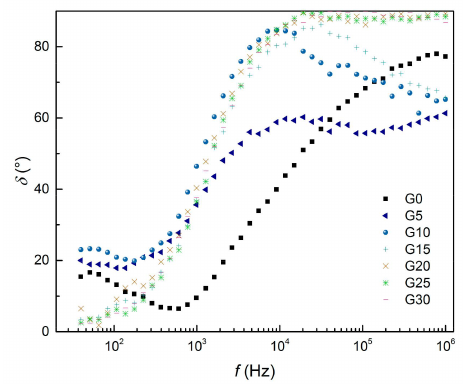
Figure 10. Loss angle of AAS composites with 0 wt%–30 wt% of graphite powder in the frequency range 40 Hz–1